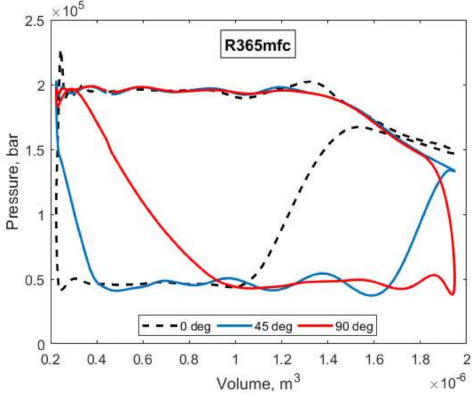
Figure 10. P–V diagram of the expander for R365mfc and different outlet port locations.